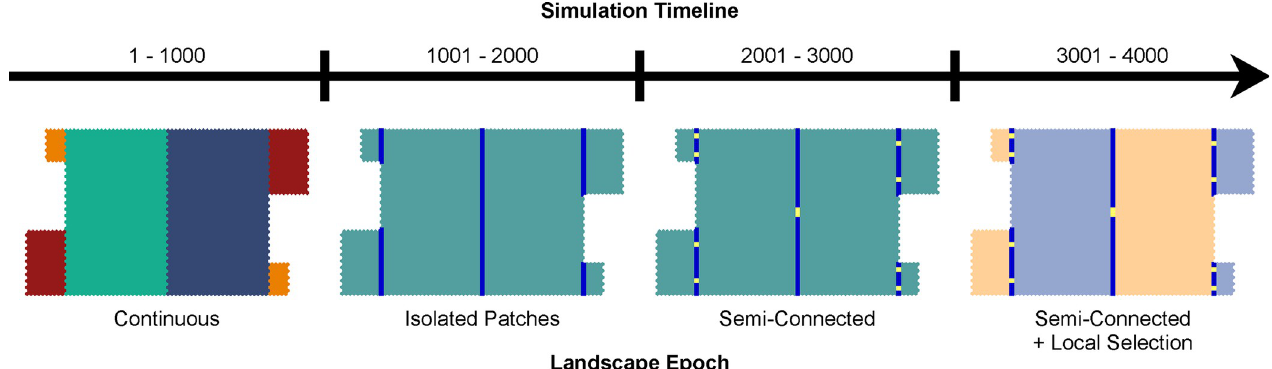
Fig 1. The progression of landscape epochs over 4000 simulation time steps. Movement barriers (shown as dark blue lines) and landscape edges are reflective. The six patches are distinguished by color within the Continuous epoch. Yellow barrier gaps, introduced at time step 2001, are of the same total length for each barrier. At time step 3001, the landscape is assigned two distinct habitat types (light blue vs. orange) that confer genotype-specific adaptive advantage to juvenile survival.